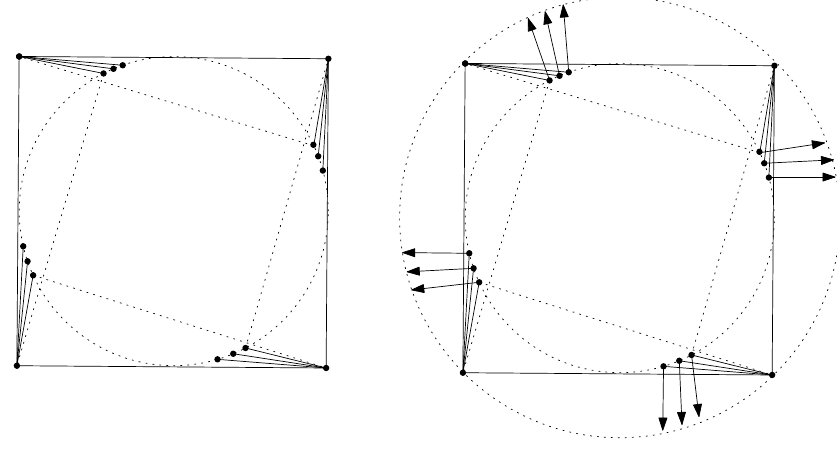
Fig. 6: Illustration for the proof of Proposition 3.3 with h = 4 and l = 3